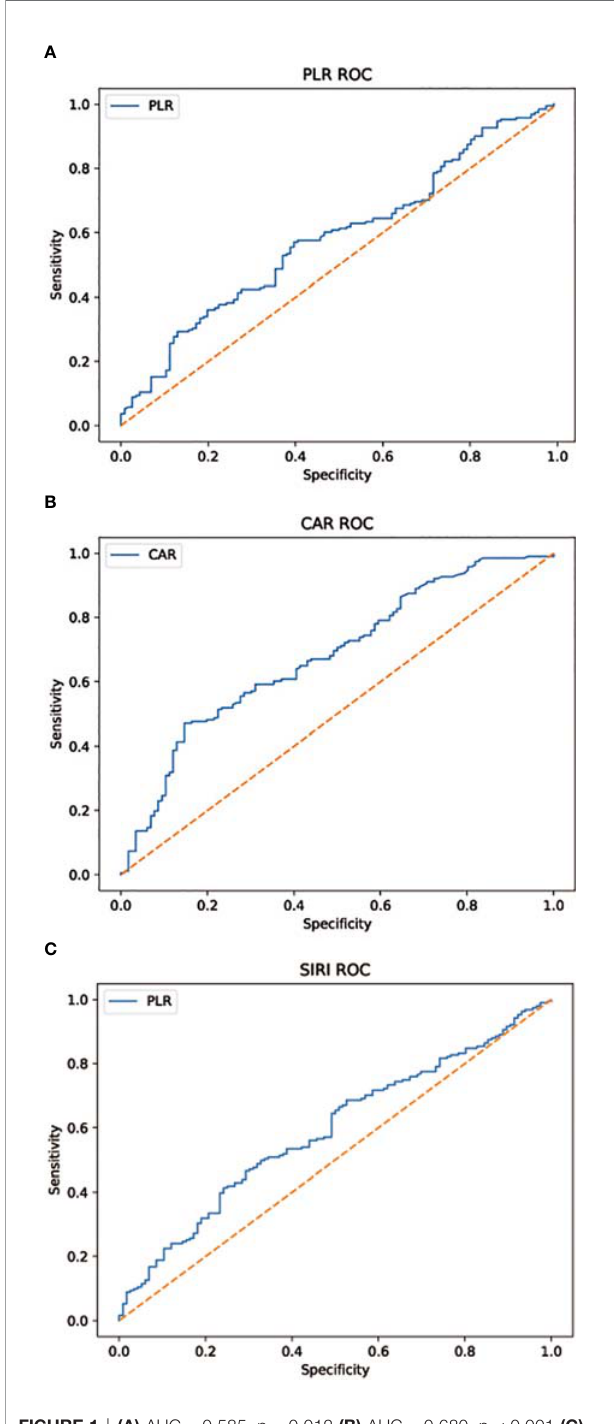
FIGURE 1 | (A) AUC = 0.585, p = 0.012 (B) AUC = 0.680, p < 0.001 (C) AUC = 0.590, p = 0.008. Subject work characteristic (ROC) curve analysis to assess the predictive value of each combination of in fl ammatory factors for the discovery of lymph node metastasis in patients with gastric cancer in the